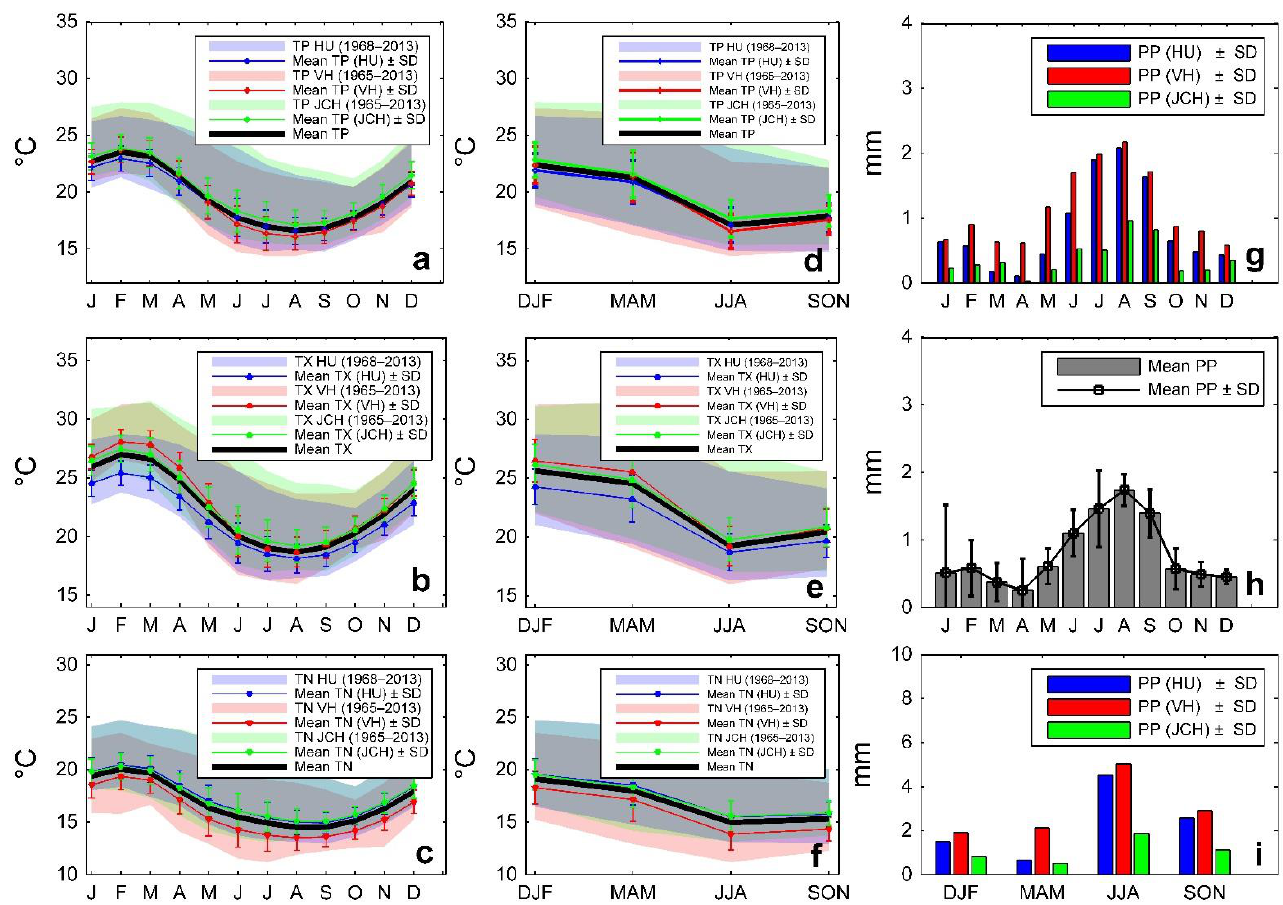
Figure 2. Monthly ( a – c ) and seasonal ( d – f ) climatology of maximum temperature (TX), minimum temperature (TN), and average temperature (TP). Monthly ( g , h ) and seasonal ( i ) precipitation (PP) in Metropolitan Lima. Climatology base period 1981-2010. Hipolito Unanue (HU), Von Humboldt (VH), and Jorge Chavez (JCH) weather stations.